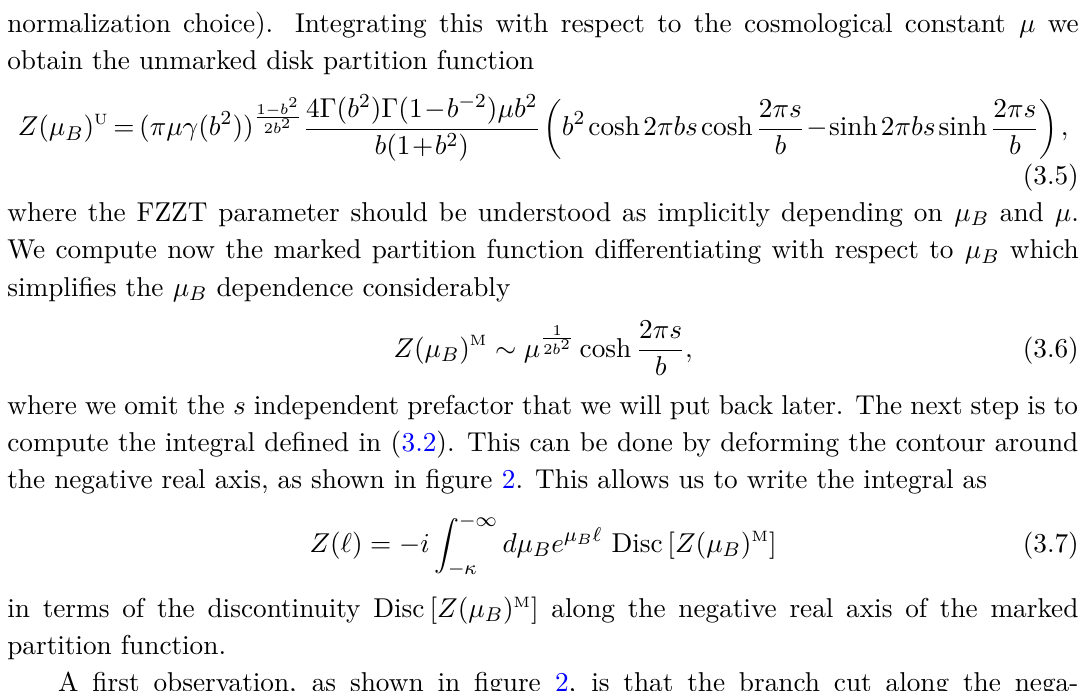
Figure 2 . Contour deformation from the original one (in green) to a deformed one that wraps the negative real axis (blue line). The segment ( − κ, 0) has no branch cut and the contour can be further deformed to the semi-infinite interval ( −∞ , − κ )